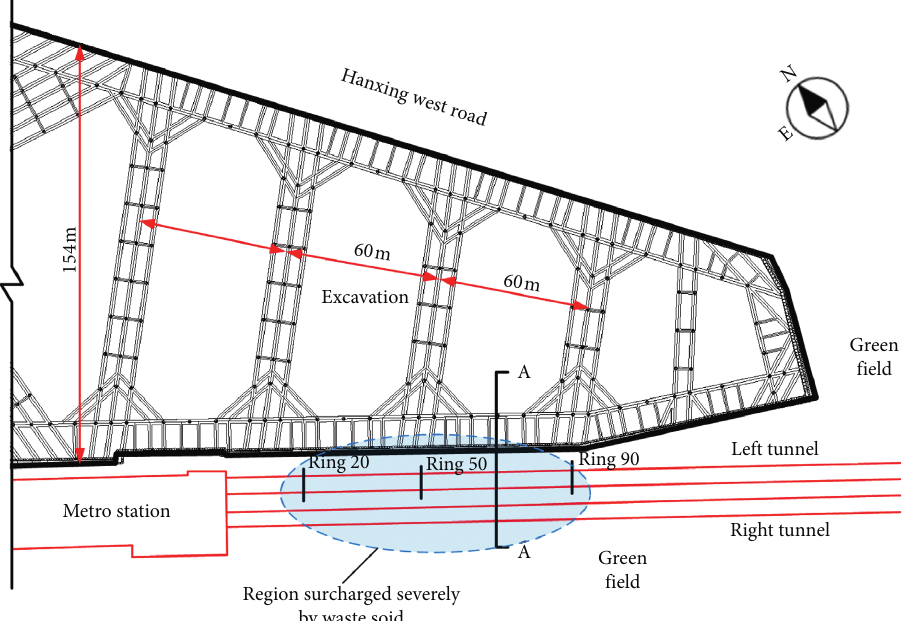
Figure 22: Plan view of the construction